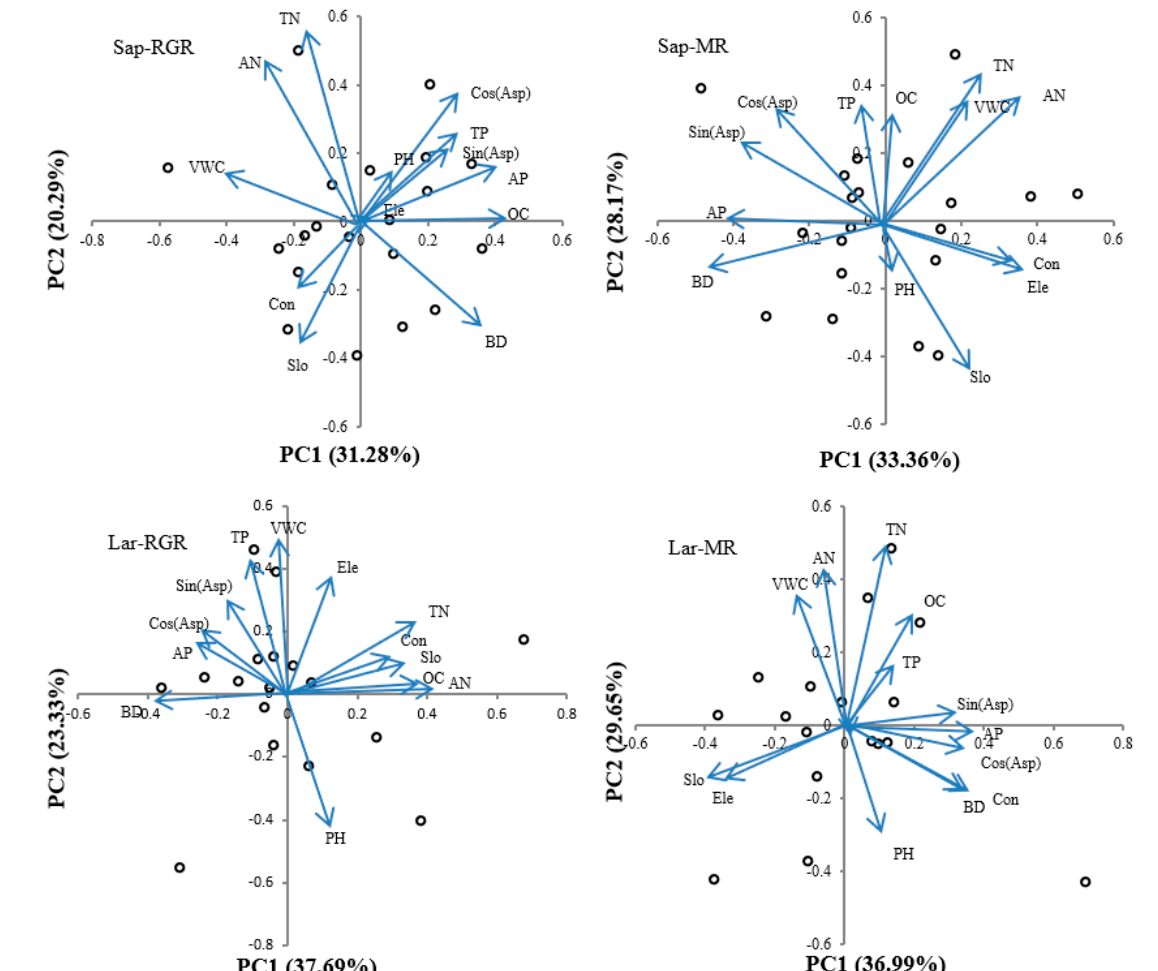
Figure 2. PCAs for topographical and soil characteristics of RGR and MR in saplings and large trees.